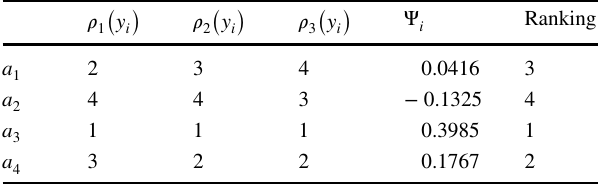
Table 13 Final ranking of the alternatives based on the Borda scores